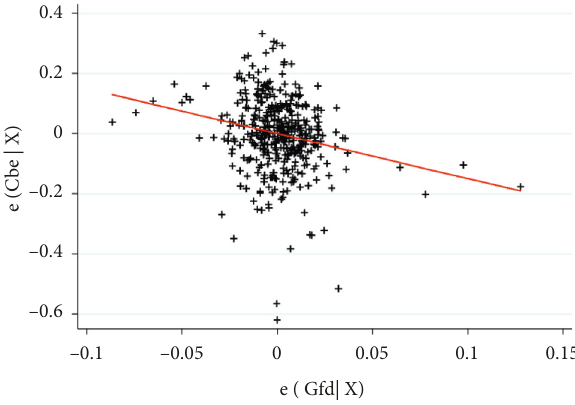
Figure 3: Partial correlation (after adding control variables).